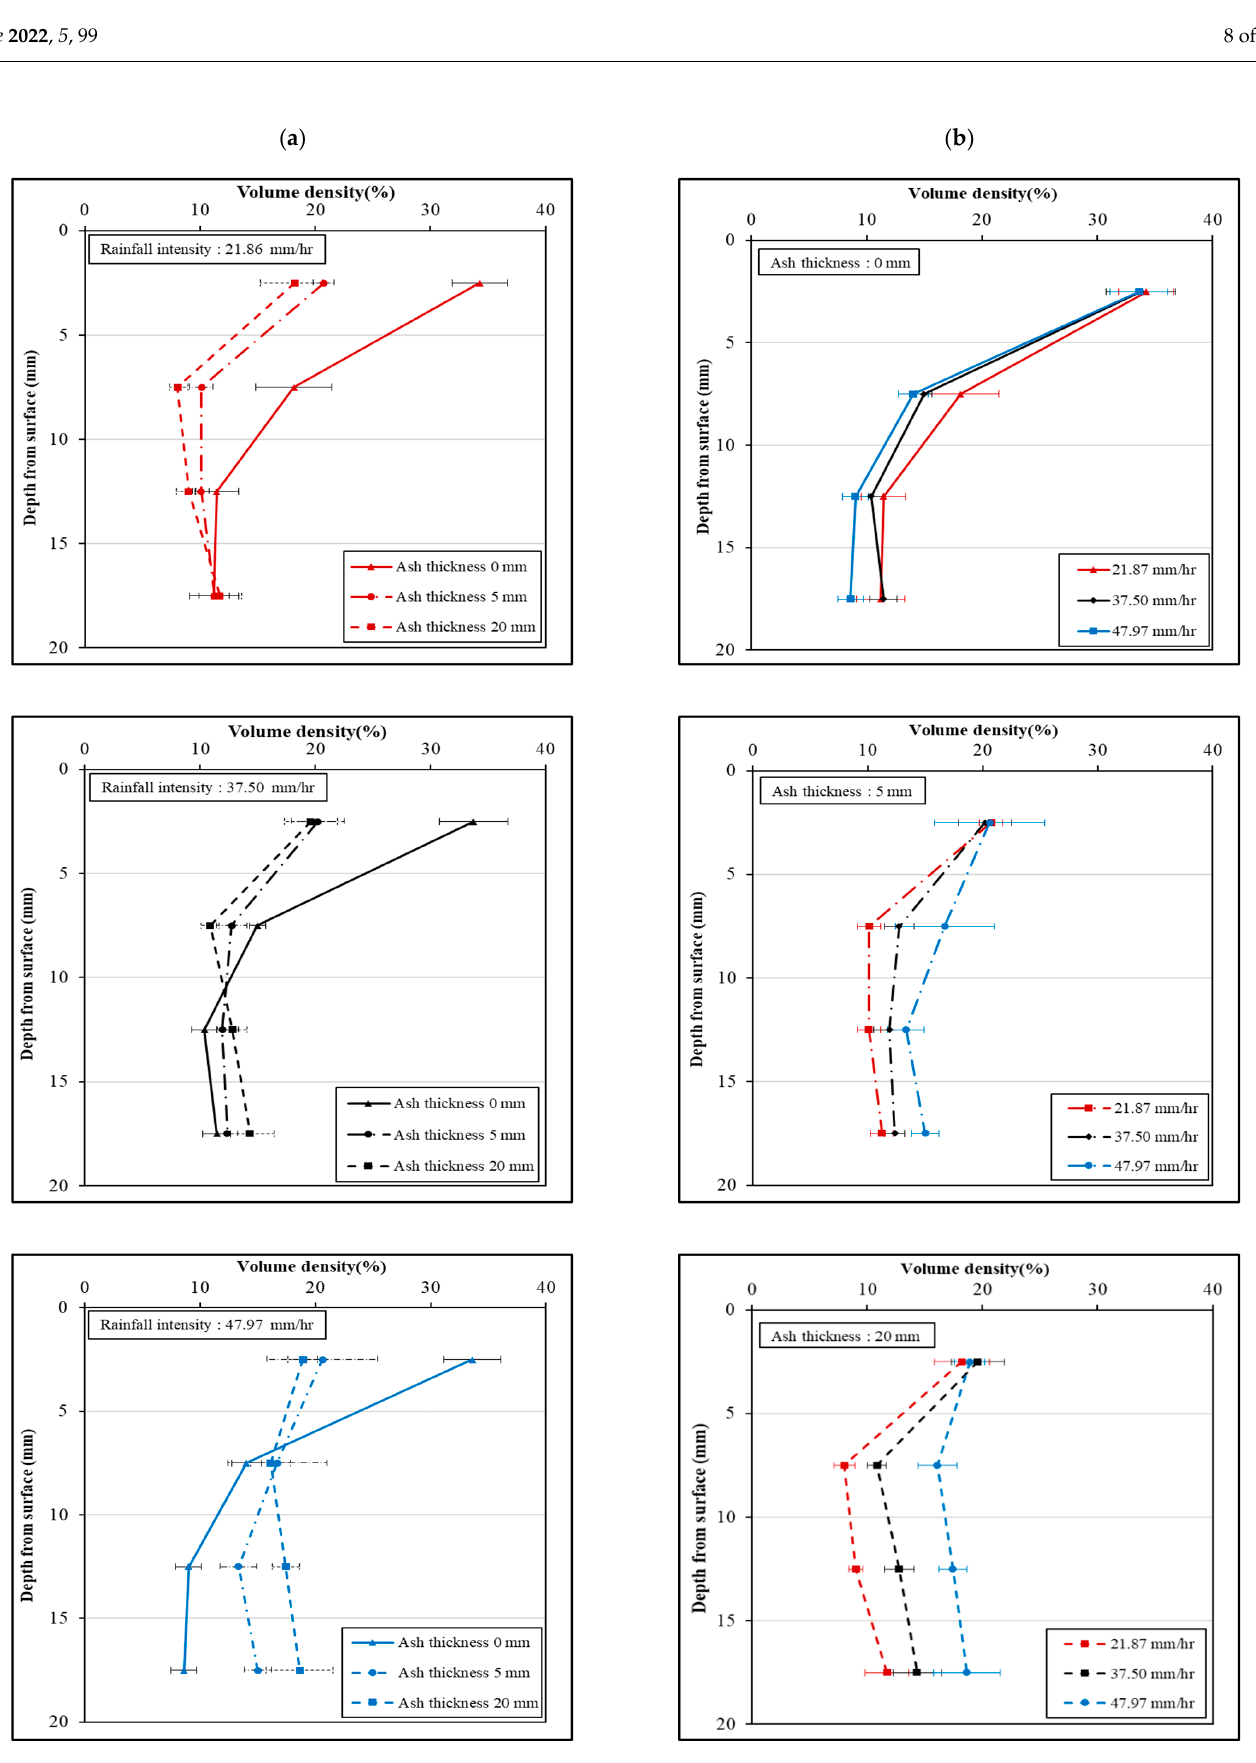
Figure 4. Variations in volume density according to ( a ) ash treatment and ( b ) rainfall intensity. The differences in the volume density of the soil pores between the no rainfall and rainfall experiments demonstrated the effects of the raindrop impact on the migration of